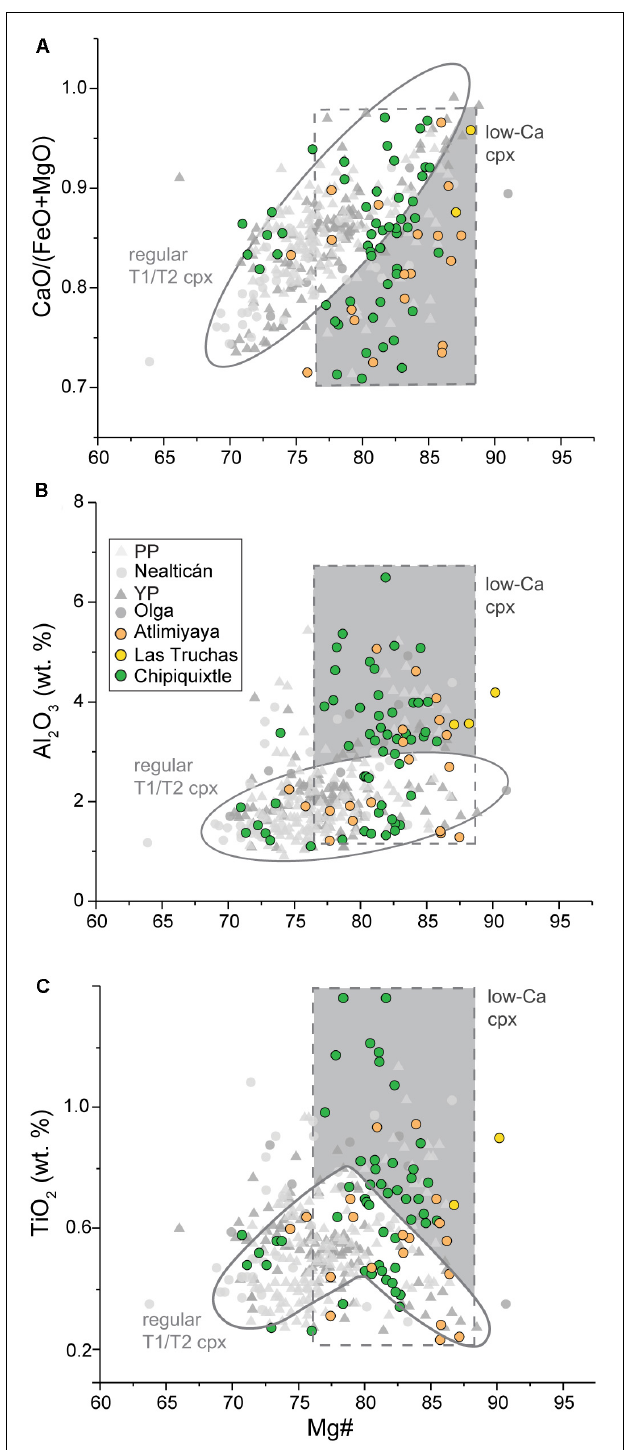
FIGURE 10 | Oxide vs. Mg# plots for PVC clinopyroxene (cpx) defining low-Ca clinopyroxene (gray shaded boxes) against regular T1/T2 clinopyroxene in flank and Plinian eruptions of the last ∼ 14.1 ka. The Chipiquixtle, Las Truchas and Atlimiyaya flank eruptions (colored symbols) are dominated by low-Ca cpx compared to other units (gre symbols). (A) CaO/(FeO + MgO). (B) Al 2 O 3 . (C) TiO 2 . See text for